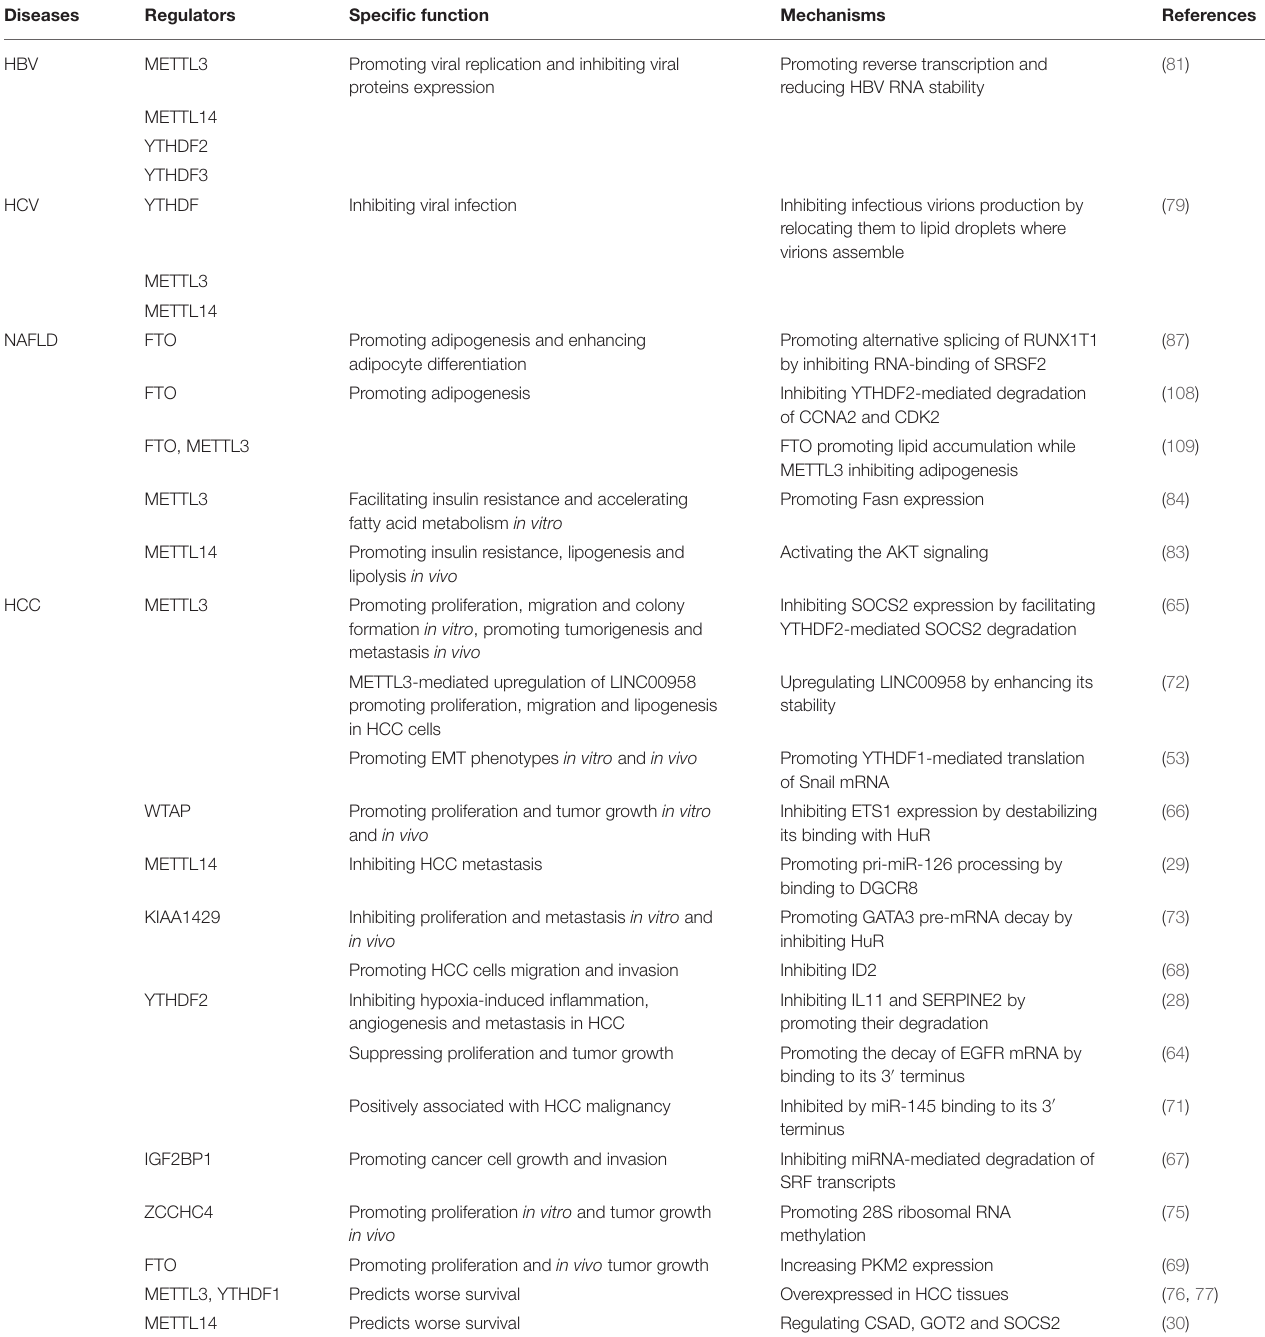
TABLE 1 | Role of m6A regulators in HCC occurrence and